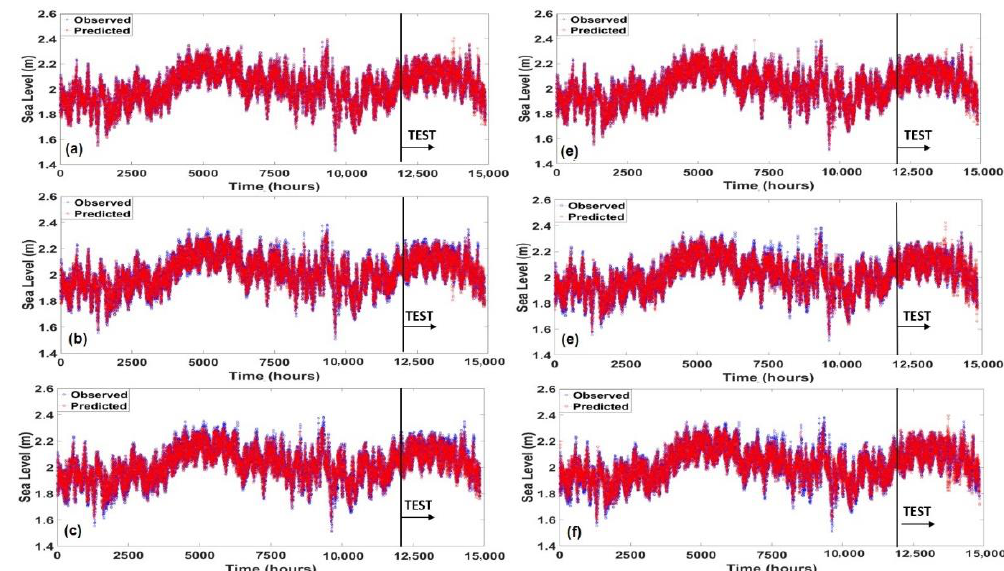
Figure 9. Adaptive neuro-fuzzy inference system predictions: ( a ) SC1 -based 1 h ahead; ( b ) SC1 -based 12 h ahead; ( c ) SC1 -based 24 h ahead; ( d ) SC2 -based 1 h ahead; ( e ) SC2 -based 12 h ahead; ( f ) SC2 -based 24 h ahead.